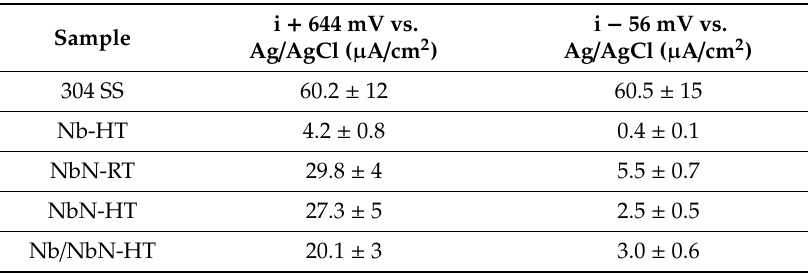
Table 9. Stable current density of coated and bare 304 stainless steel after potentiostatic measurements for 30 min.